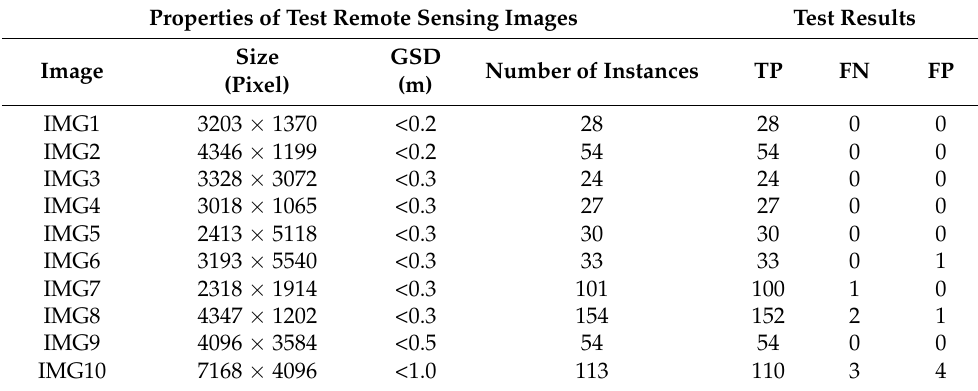
Table 1. Properties of each test remote sensing image and its test results. Properties of Test Remote Sensing Images